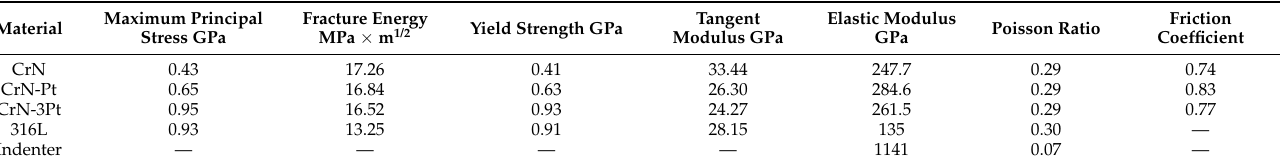
Figure 1. Schematic diagram of the overall assembly of the two-dimensional model. Table 3. Parameters of the finite element simulation model of the scratch process.